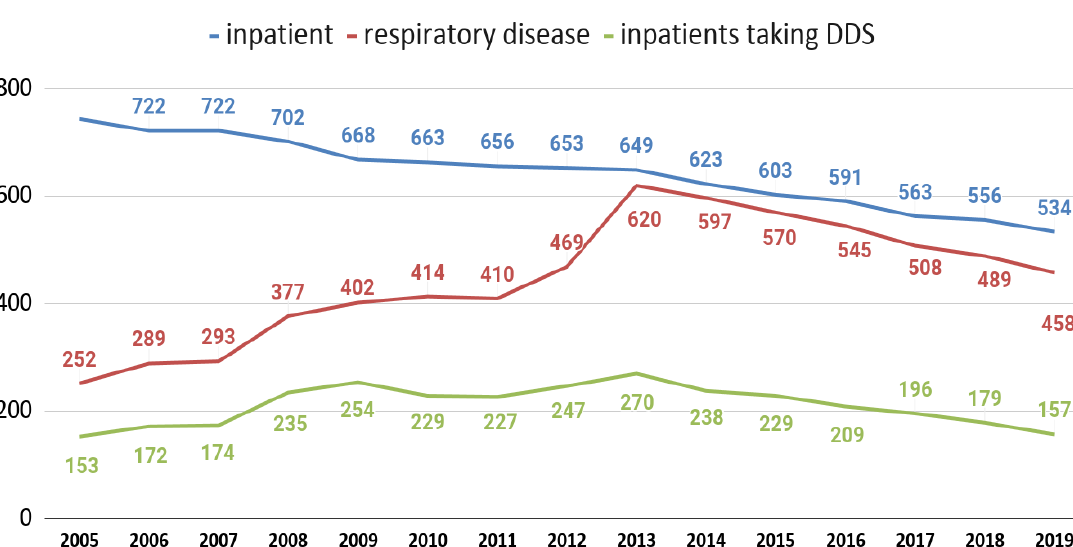
Figure 3. Respiratory infectious diseases (RIS) of Hansen’s patients at Sorokdo National Hospital in Korea. International Classification of Diseases (ICD-9, 10) of RIS are J00 (acute nasopharyngitis), J01 (acute sinusitis), J01.8 (other acute sinusitis), J02 (acute pharyngitis), J02.9 (acute pharyngitis, unspecified), J03 (acute tonsillitis), J03.0 (streptococcal tonsillitis), J03.9 (acute tonsillitis, unspecified), J04.0 (acute laryngitis), J06.0 (acute laryngopharyngitis), J06.9 (acute upper respiratory infection,